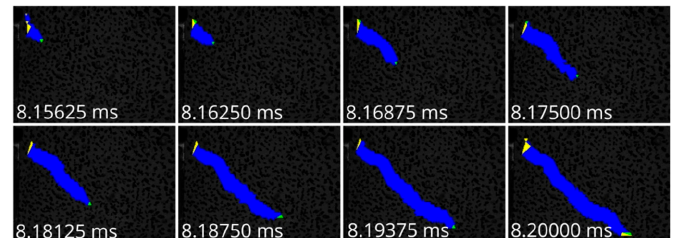
imaging rate, time stamps in milliseconds.